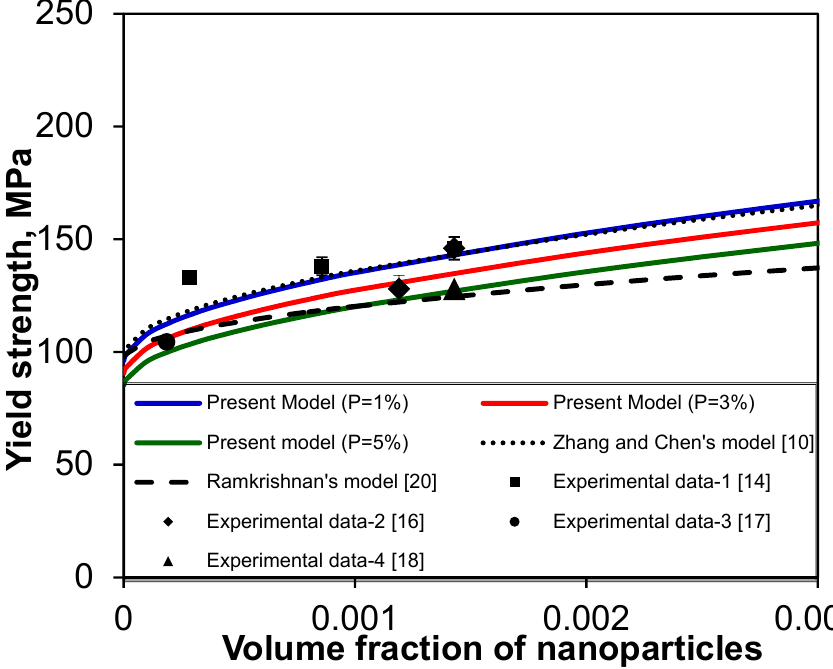
Figure 5. Comparison of the present model (solid curves) with the experimental data reported in [14,16–18], along with Zhang and Chen’s model [10] and Ramakrishnan’s model [20], for CNT-reinforced Mg